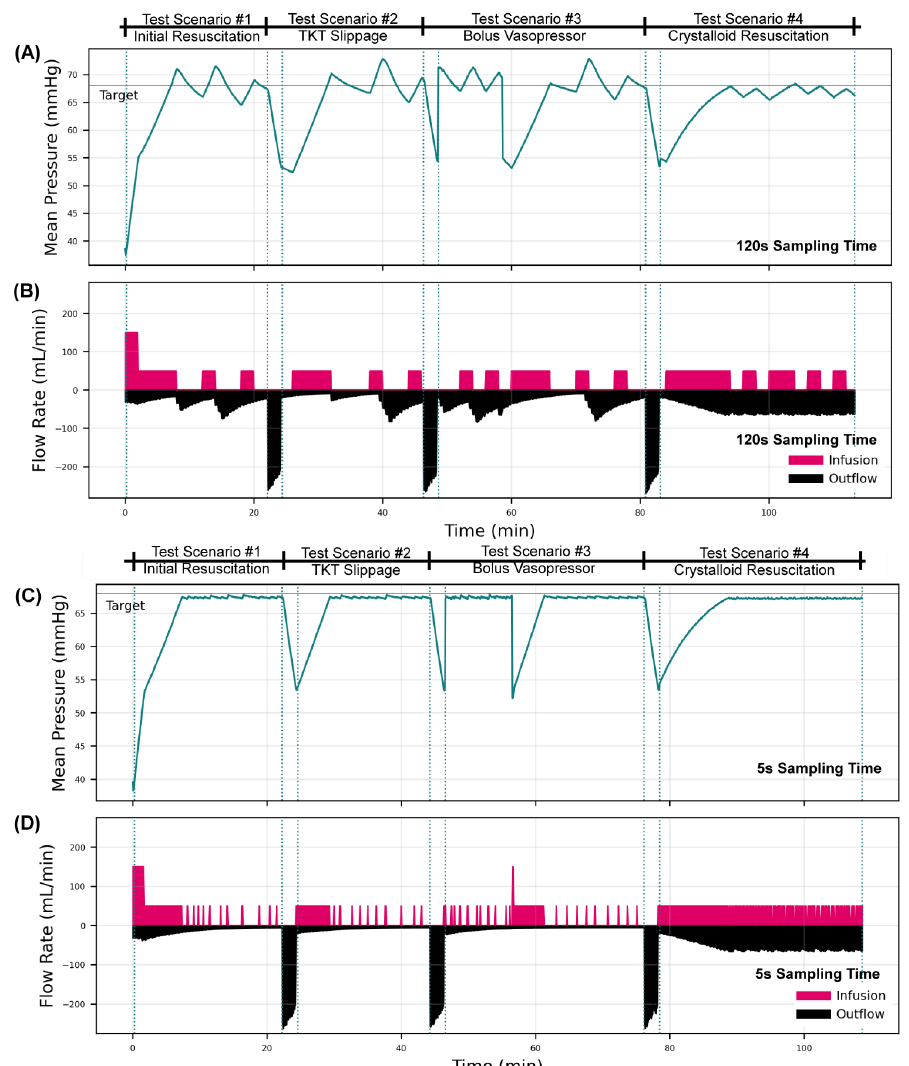
Figure 5. Decision Table Resuscitation Controller Performance with a low hemorrhage rate in the automated hemorrhage test platform. Testing results are shown for a decision table controller configured with (A,B) a 120 s sampling rate or (C,D) a 5 s sampling rate for receiving pressure signal and sending infusion pump rate commands. Results are shown for (A,C) the mean pressure of the system and (B,D) the infusion and outflow (hemorrhage + urine flow rates) of the system. The overall testing scheme was broken up into four scenarios, which begin at the first dotted vertical lines and end at the next dotted line, repeated for each scenario. The scenarios were as follows: (i) an initial hemorrhage to decrease MAP to 40 mmHg with ongoing hemorrhage clotting with time; (ii) a severe and rapid loss of blood, mimicking tourniquet failure; (iii) similar rapid blood loss followed by bolus vasopressor delivery lasting for 10 min; and (iv) rapid blood loss with a non-clotting hemorrhage and resuscitation with crystalloid. Low bleed corresponds to slower initial bleed rates in the first phase and continuous bleed in phase four. See HATRC Experimental Setup and Hemorrhage Test Scenarios methods for more information on the bleed logic and testing setup.